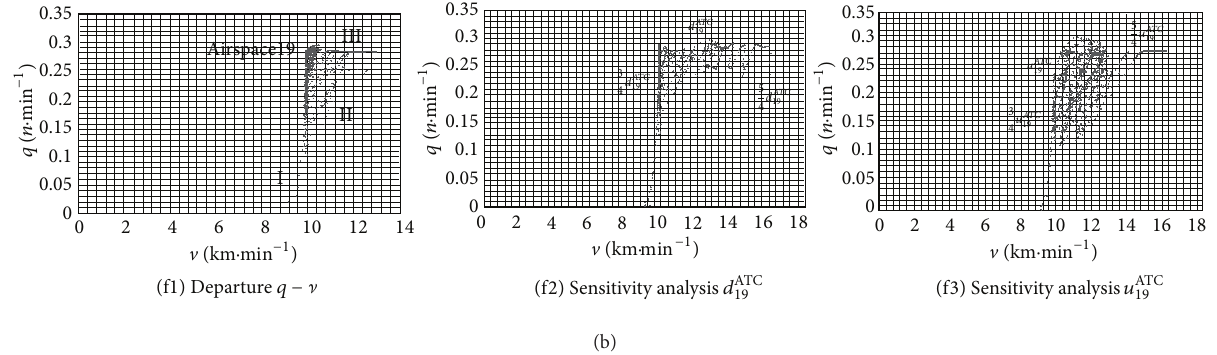
Figure 9: Scatter diagrams of basic arrival/departure flow characteristic parameters in terminal